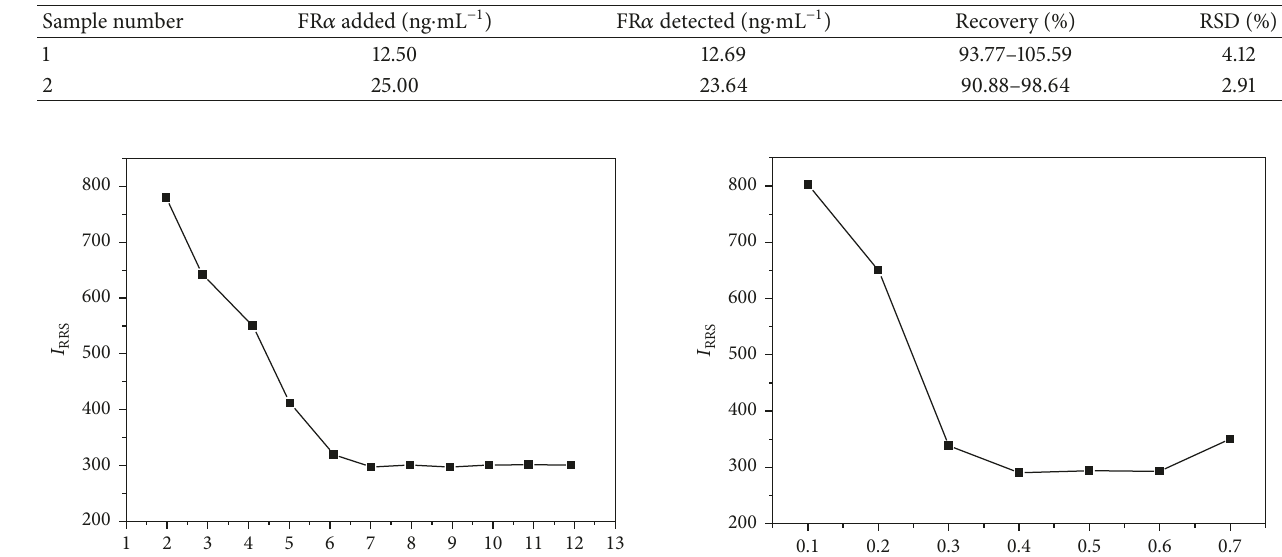
Figure 2: TEM images for antibody-modified Au NPs probe (a) and the interaction between the probe and FR 𝛼 ((b) concentration of FR 𝛼 , 12.50 ng ⋅ mL −1 ). Table 2: Determination of FR 𝛼 in real samples ( 𝑛 = 10).